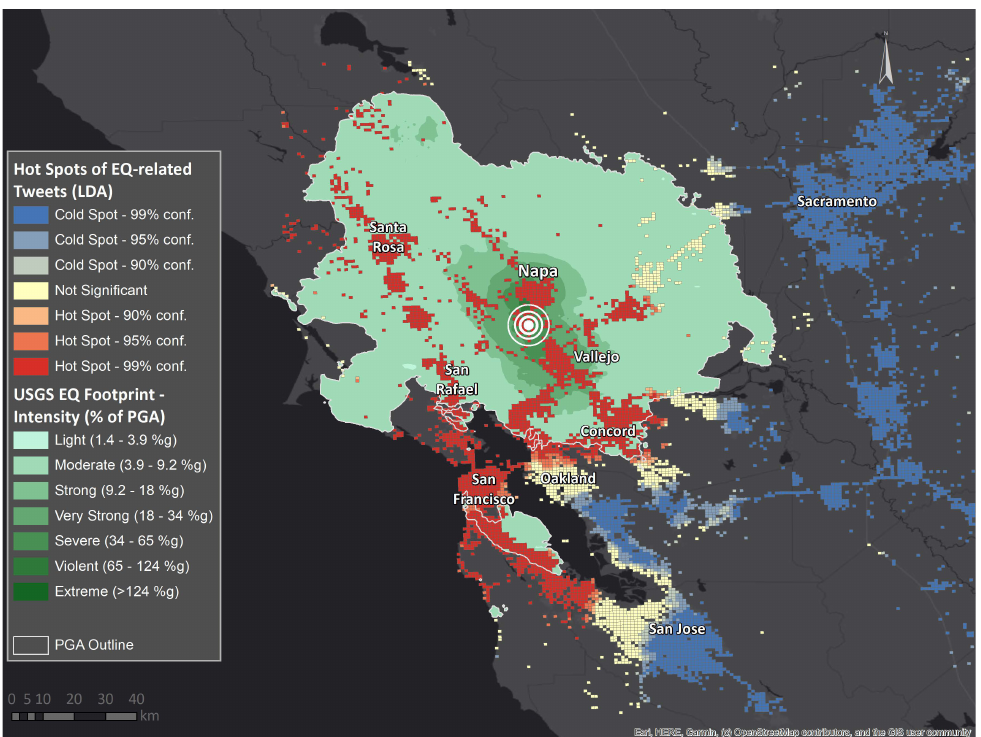
Figure 7. Earthquake hot and cold spots obtained using GLDA V2 compared to the US Geological Survey (USGS) [43] footprint measuring the intensity in per cent of the peak ground acceleration (PGA).